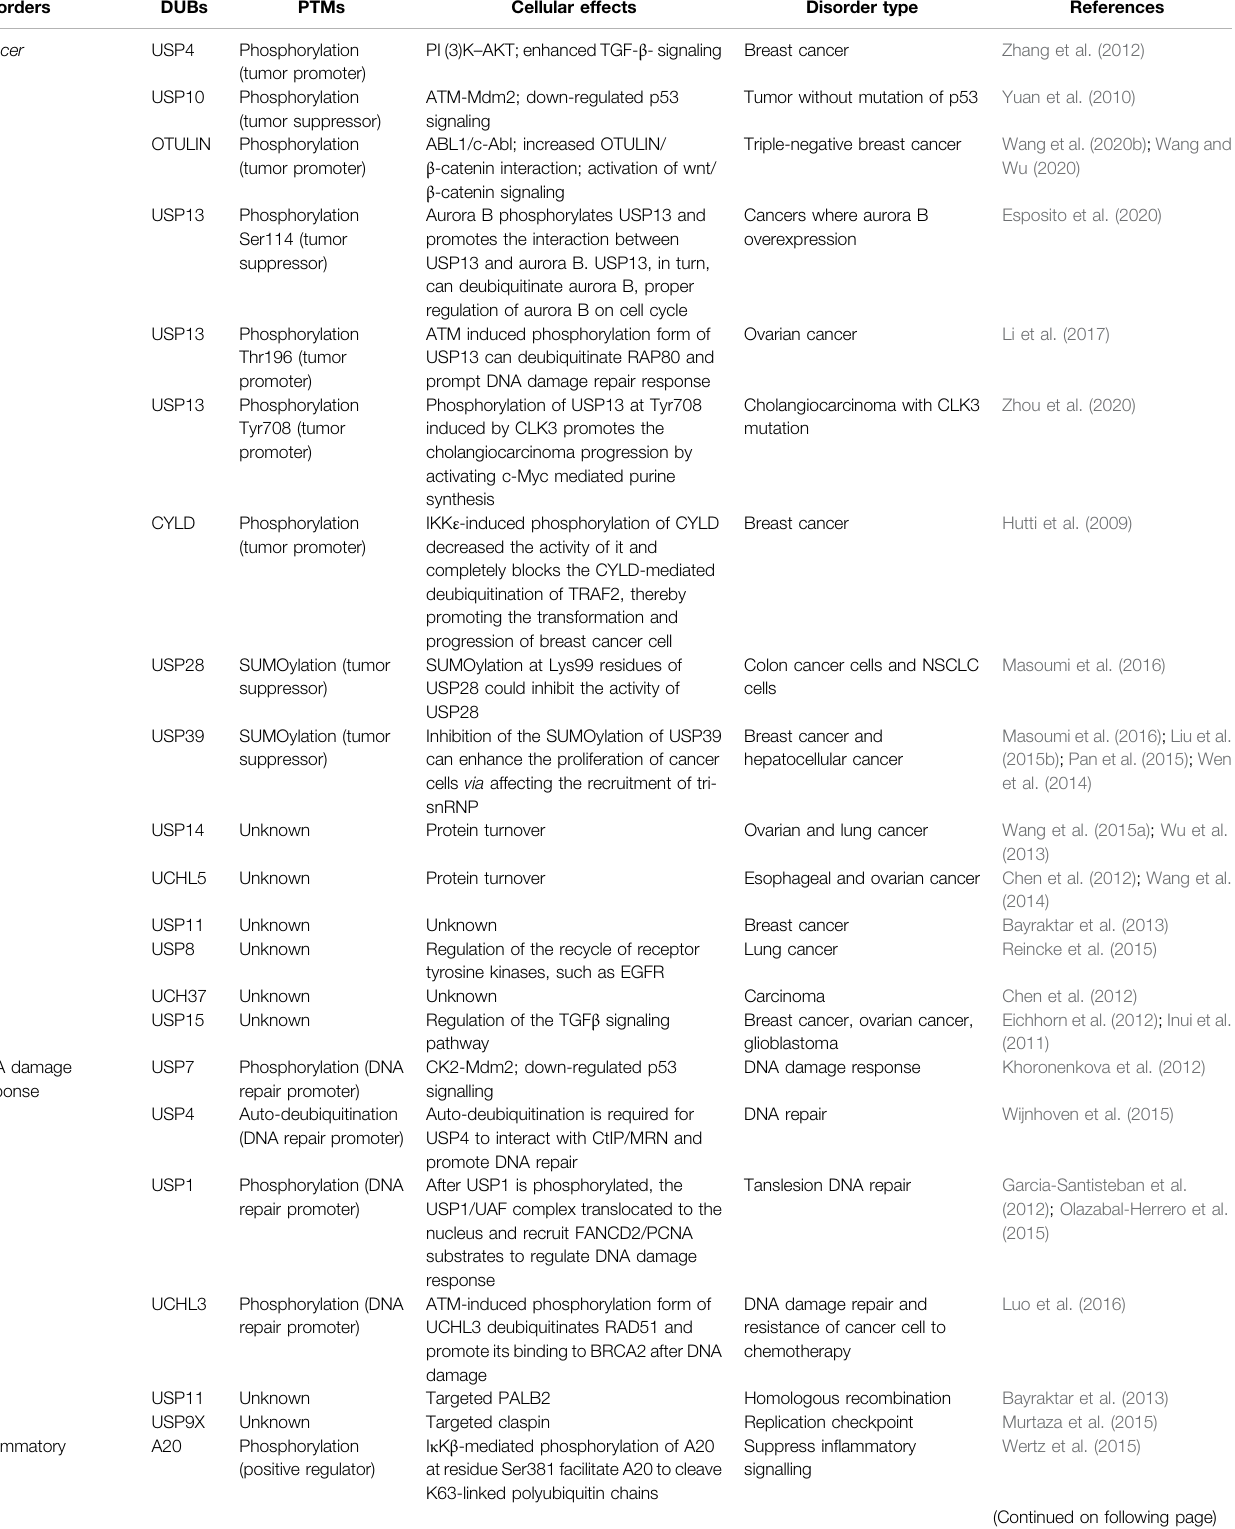
TABLE 3 | PTMs of DUBs induced cellular effects and